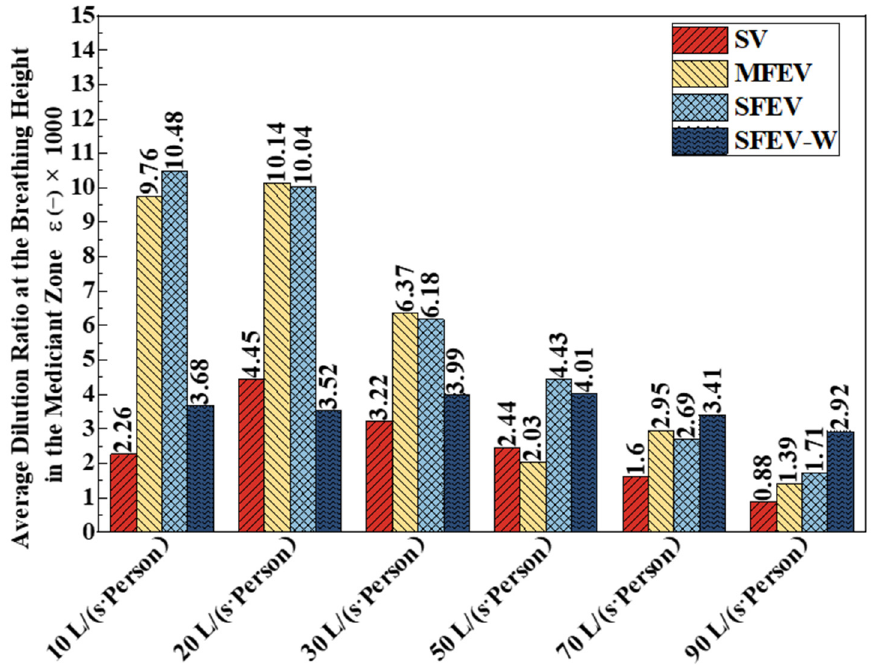
Figure 9. Average dilution ratio ( ε ) at the breathing height y = 1.1 m in the MSZ under different ventilation strategies with different ventilation rates. ventilation strategies with different ventilation